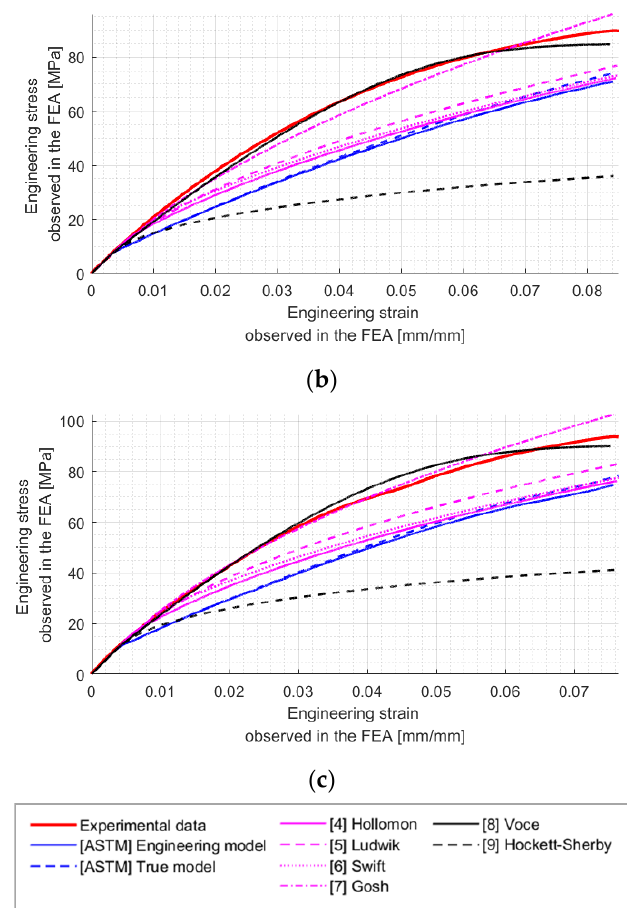
Figure 7. Experimental curves and finite element analysis (FEA) results: ( a ) inverse models of GFRP wt 20% GF; ( b ) inverse models of GFRP wt 30% GF; ( c ) inverse models of GFRP wt 40% GF.